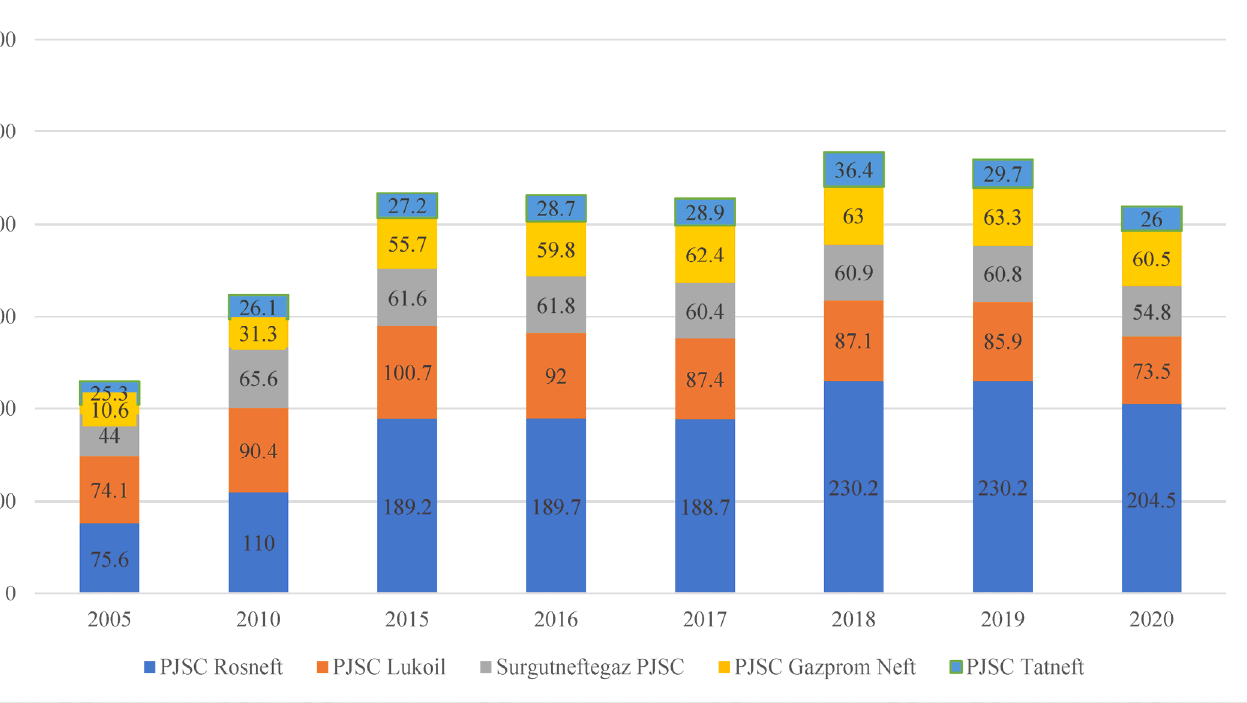
Figure 5. Dynamics of oil production by Russian vertically integrated companies for 2005–2020, million tons. Compiled by the authors according to: The annual report of PJSC NK Rosneft. 2020.